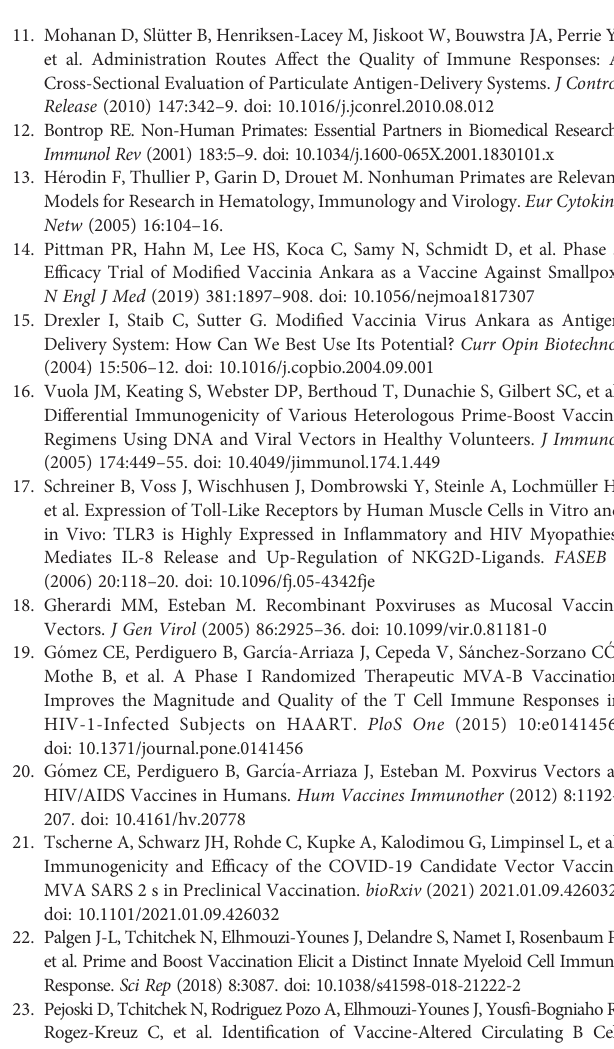
Supplementary Figure 4 | Skin and lymph node tissue after MVA immunization by the SC or ID route Supplementary Figure 5 | Gating strategy for the fl ow cytometry of tissue samples. Supplementary Table 1 | Panel used for CyTOF staining Supplementary Table 2 | Panel used for FlowCytometry staining Supplementary Table 3 | Dataset of innate immune